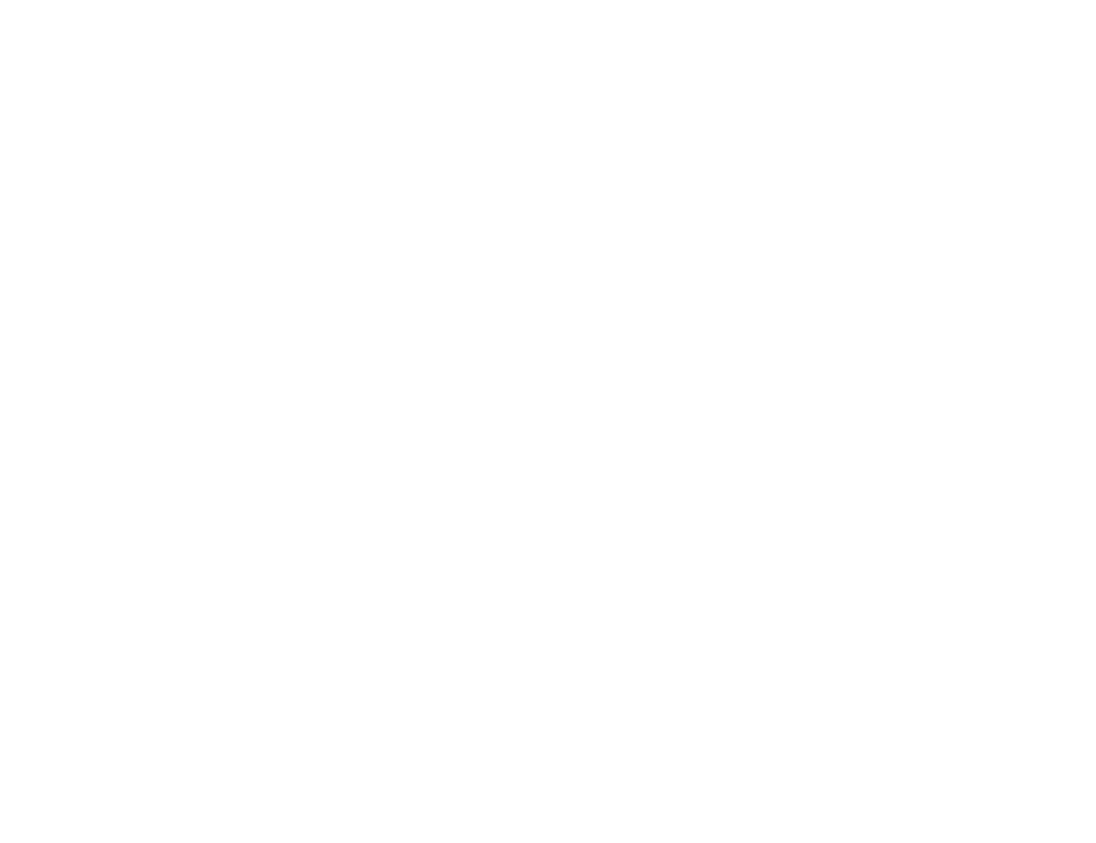
saturated vapor, respectively). Odorants were: 2-hexanone ( n = 5), hexanal ( n = 1), benzaldehyde ( n = 2), heptanal ( n = 4), isoamyl acetate ( n = 1). (C) Spike rates from loose-patch recordings recorded in two different trials (measured as a number of action potentials per respiratory cycle) before (open circles) and during (filled circles) odorant presentations plotted against each other ( n = 4, 5, and 4 trial pairs for 0.3, 1.5, and 9% of saturated vapor). The odorant was 2-hexanone ( n = 8 cells). Both lines represent the linear least squares fits to the respective set of data. Note that the slope of each fit line in ( A and C ) (the number near the line) is close to 1 suggesting that there are little or no differences in the mean response between the two